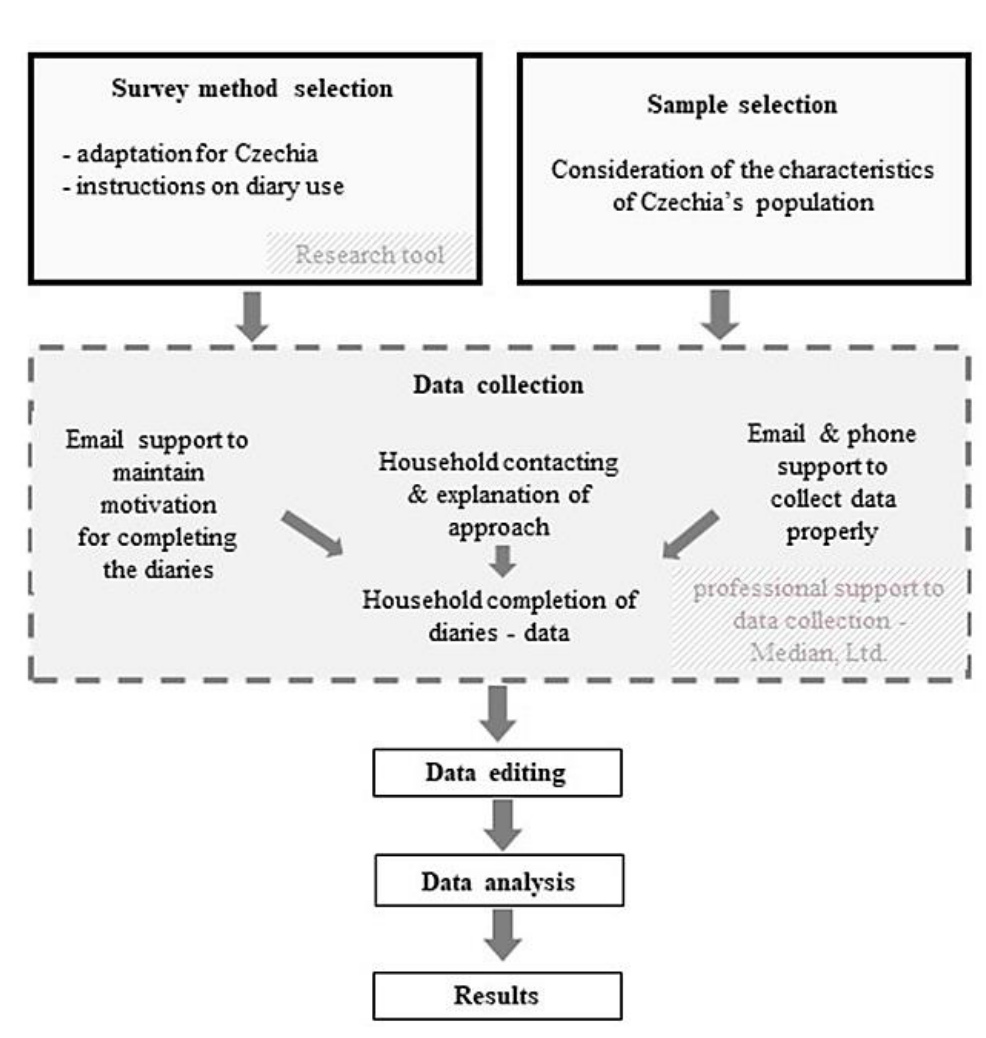
Figure 1. A flowchart with main methodological steps.